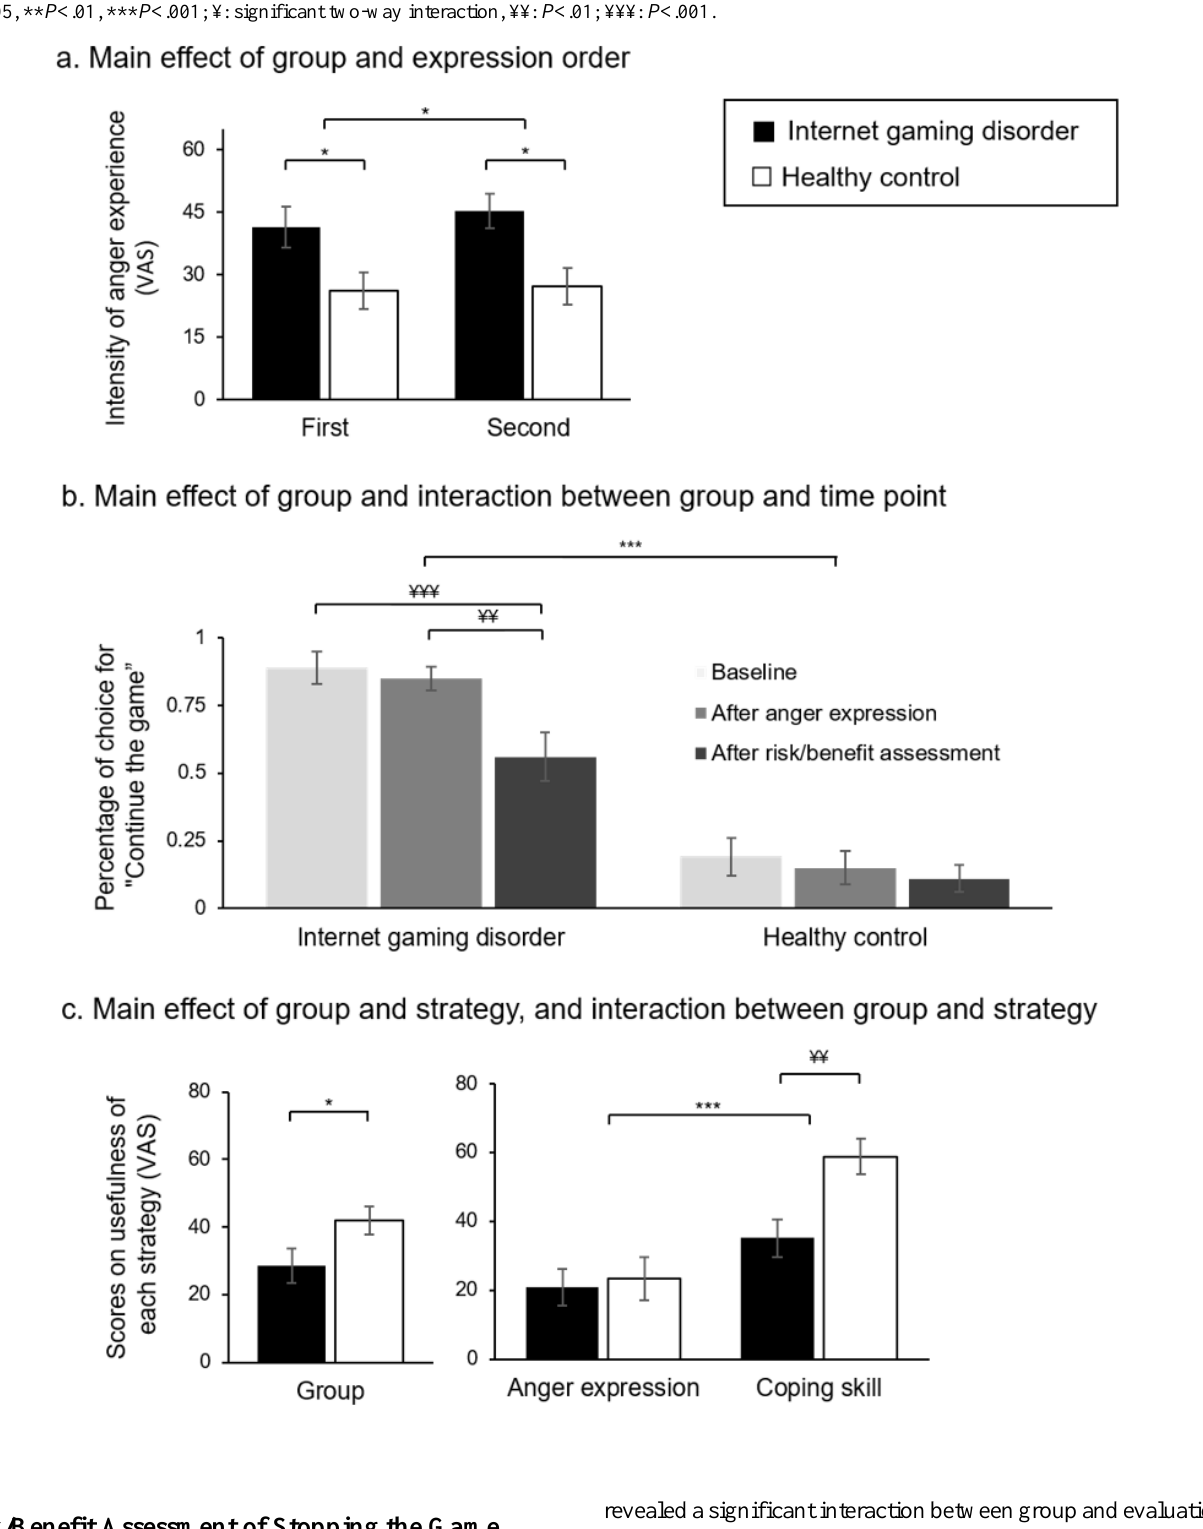
Figure 4. Results of analyses of 3 dependent variables. (a) Mean ratings for the intensity of the anger experience; (b) mean percentage of response choice for “continue the game”; (c) mean ratings for usefulness of each strategy. Error bars represent SE of the mean. *: group or condition